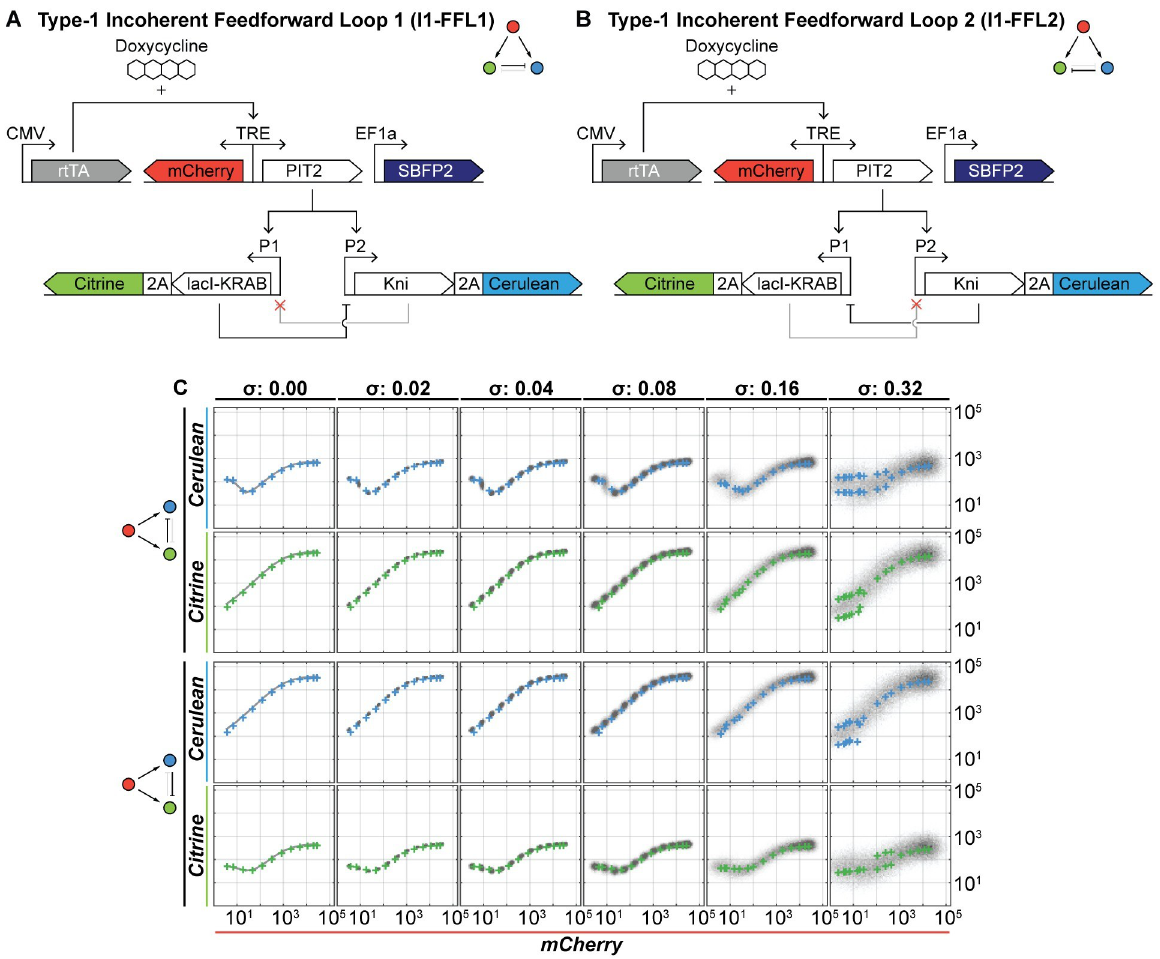
Fig 6. Results of PFAFF analysis on simulated I1-FFLs flow cytometry data sets. (A) and (B) Circuit architecture of two additional I1-FFLs. (C) Simulated flow cytometry data set of the bin that lies at the transfection reference protein’s global mean (transfection reference: SBFP2) at different gene expression noise levels σ (columns) ranging from 0.00–0.32 is processed by PFAFF. The plots show the input/output curves extracted by PFAFF (colored crosses; top row: Cerulean, bottom row: Citrine) atop of the simulated stably integrated circuit at the indicated gene expression noise level σ (grey density plot). Both I1-FFLs show adaptive behaviors in their respective outputs.